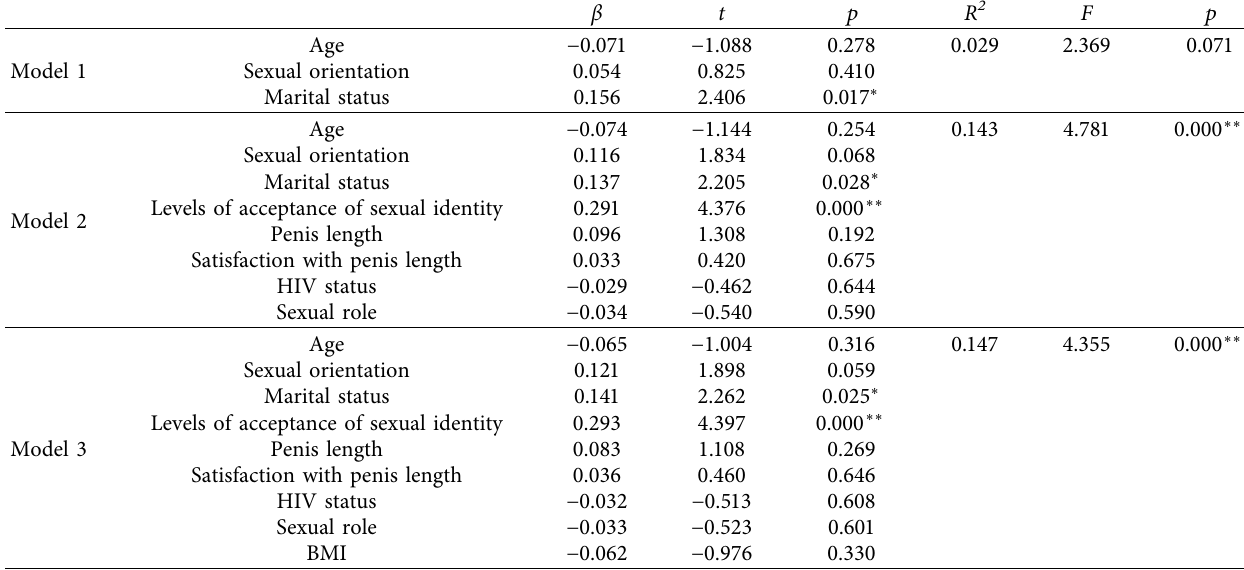
Table 4: Hierarchical multiple regression analysis predicting sexual